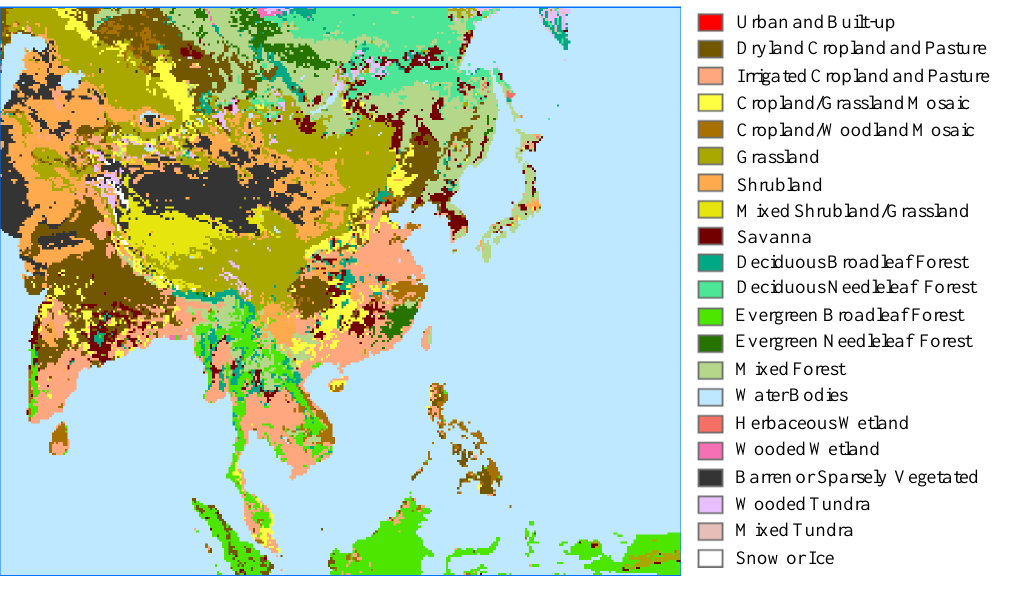
Figure 4. The geographic distribution of 21 LCC categories over the Asia RCM